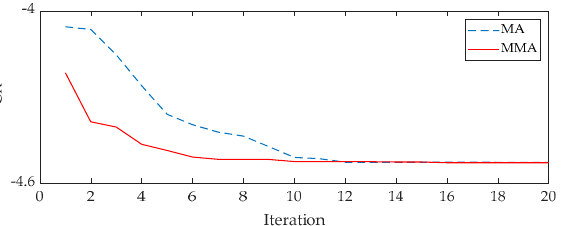
Figure 10. The results of every iteration for the outer fault signal: red line for the MMA and blue line for the raw MA.